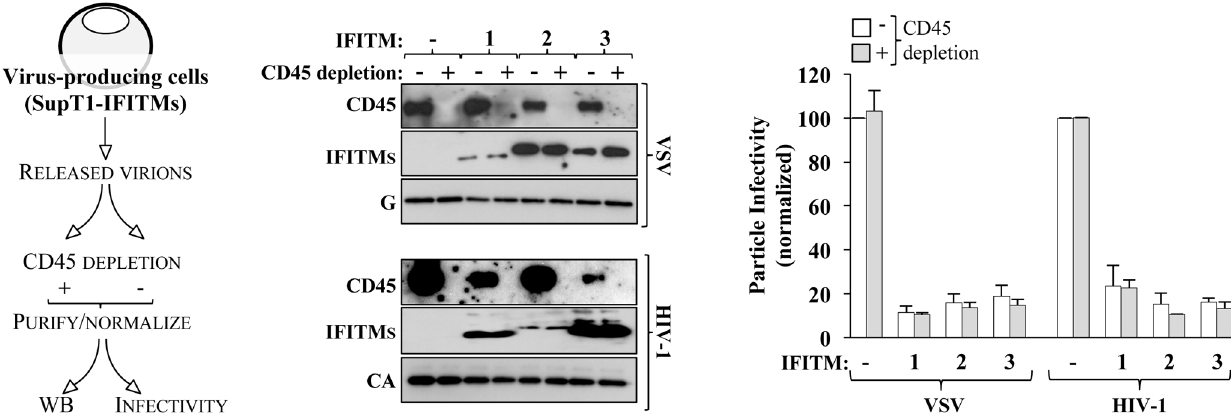
Fig 5. CD45 depletion excludes a potentially confounding role of exosome-incorporated IFITMs on virion infectivity. SupT1 cells stably expressingthe different IFITMs were infected with HIV-1 and VSV. At a late time after infectionof the cell culture, supernatants containing newly- producedvirions were harvestedand dividedin two fractions that were either incubatedwith CD45-conjugatedmicrobeads or left untreated. After the microbeads removal, virion particles were purifiedby ultracentrifugation, normalizedand then used for WB and infectivity analyses. The WB panelspresent typical results obtained,whilethe graph presents averages and SEM obtainedin 3 independentexperiments. No statistically significantdifferences were observedbetweendepletedand non-depleted fractions, after a Student t test.